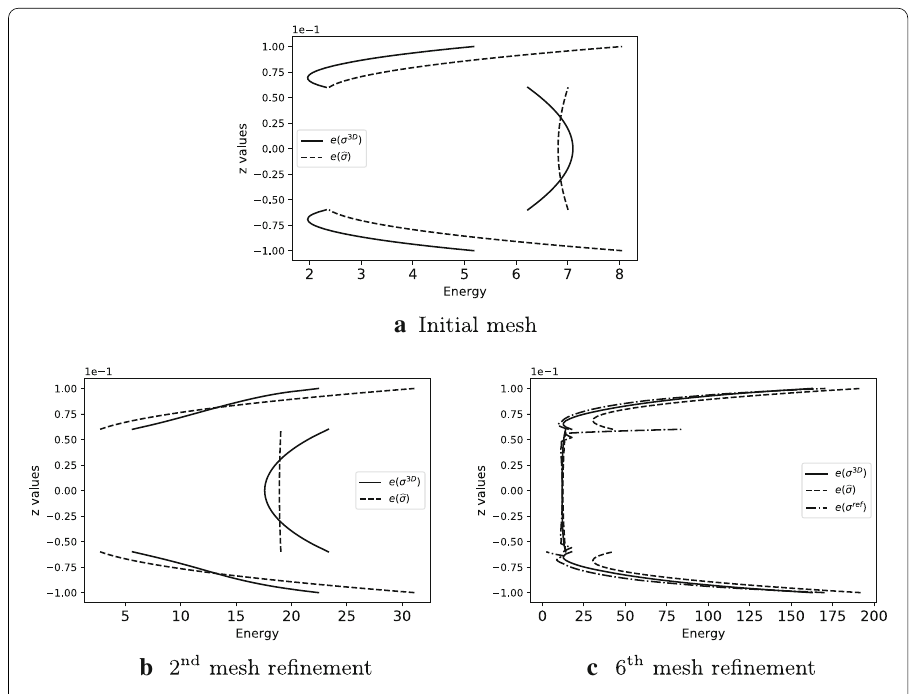
Fig. 7 Energy densities across the plate thickness computed for σ 3 D and (cid:13) σ at the plate edge for n = 3